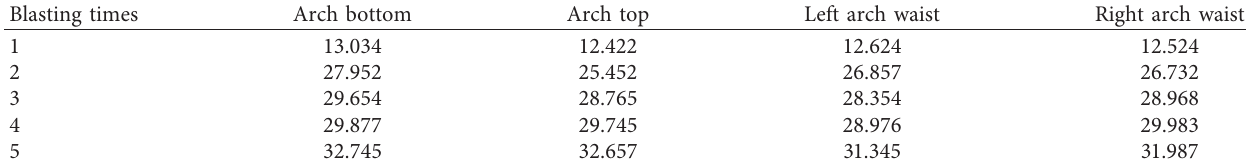
Table 5: Peak value of vibration velocity at each measuring point of profile 1-1 (10 − 2 m/sec). Blasting times Arch bottom Arch top Left arch waist Right arch waist